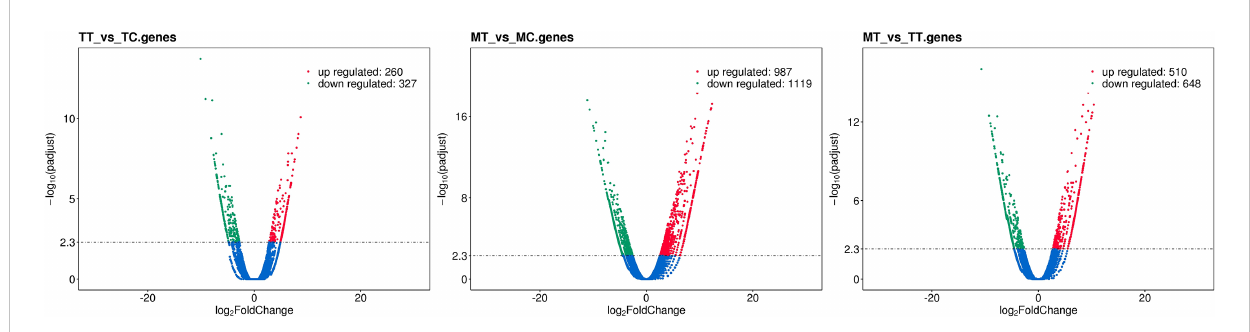
FIGURE 5 Volcano plots of DEGs in the pairwise comparisons and pathway enrichment. (A) Volcano plot of DEGs in the TT vs. TC comparison. Green dots represent genes upregulated in Turpentine Treated. Red dots represent genes upregulated in Turpentine Control. (B) Volcano plot of DEGs in the MT vs. MC comparison.Green dots represent genes upregulated in Mylepelian Treated. Red dots represent genes upregulated in Mylepelian Control. (C) Volcano plot of DEGs in the MT vs. TT comparison.Green dots represent genes upregulated in Mylepelian Treated. Red dots represent genes upregulated in Turpentine Treated. x-axis: fold change in gene expression between different samples; y-axis: statistical signi fi cance of the differences represented by red